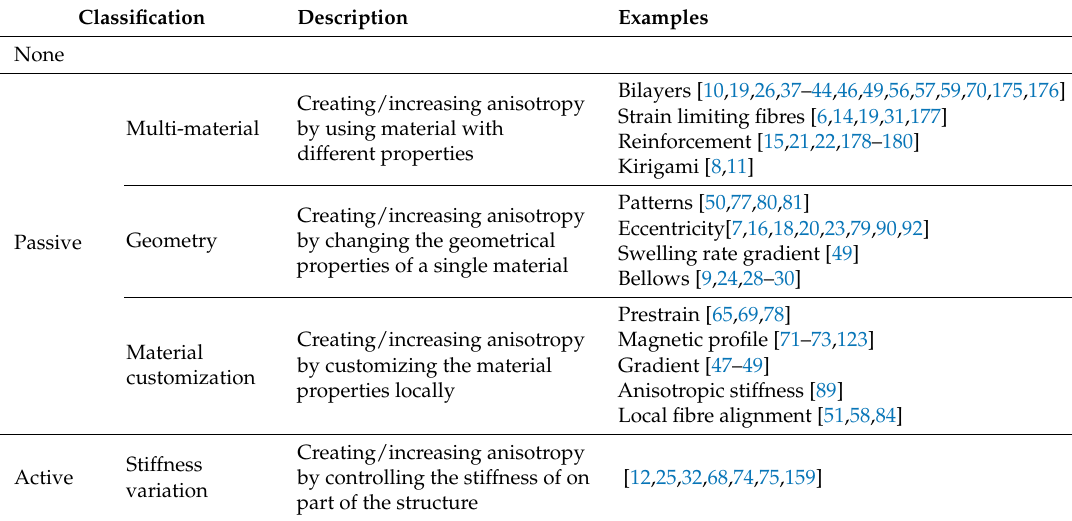
Table 2. Classification of the different types of